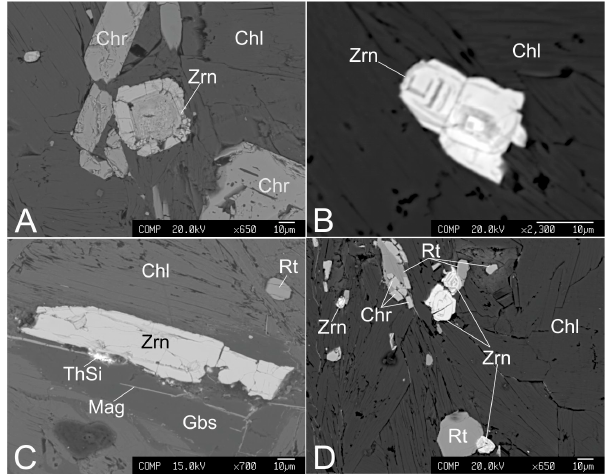
Figure 8. BSE images of zircon crystals in the matrix (sample 105C). ( A ) and ( B ) Apparently zoned crystals; ( C ) Mega-crystal associated with a Th-silicate. The dark gray mass around zircon is gibbsite with thin bands of magnetite (light gray); ( D ) Zircon crystals in close association with rutile in the matrix. Abbreviations: Chl = chlorite, Chr = chromite, Gbs = gibbsite, Mag = magnetite, Rt = rutile, ThSi = Th-silicate, Zrn = zircon.